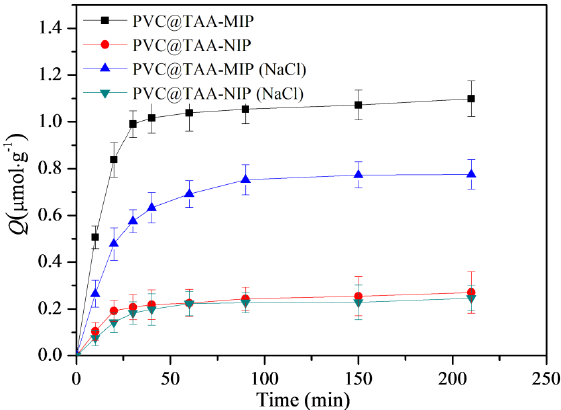
Figure 8. Binding kinetics of PVC@TAA − MIP and PVC@TAA − NIP toward BSA in the absence or presence of NaCl.